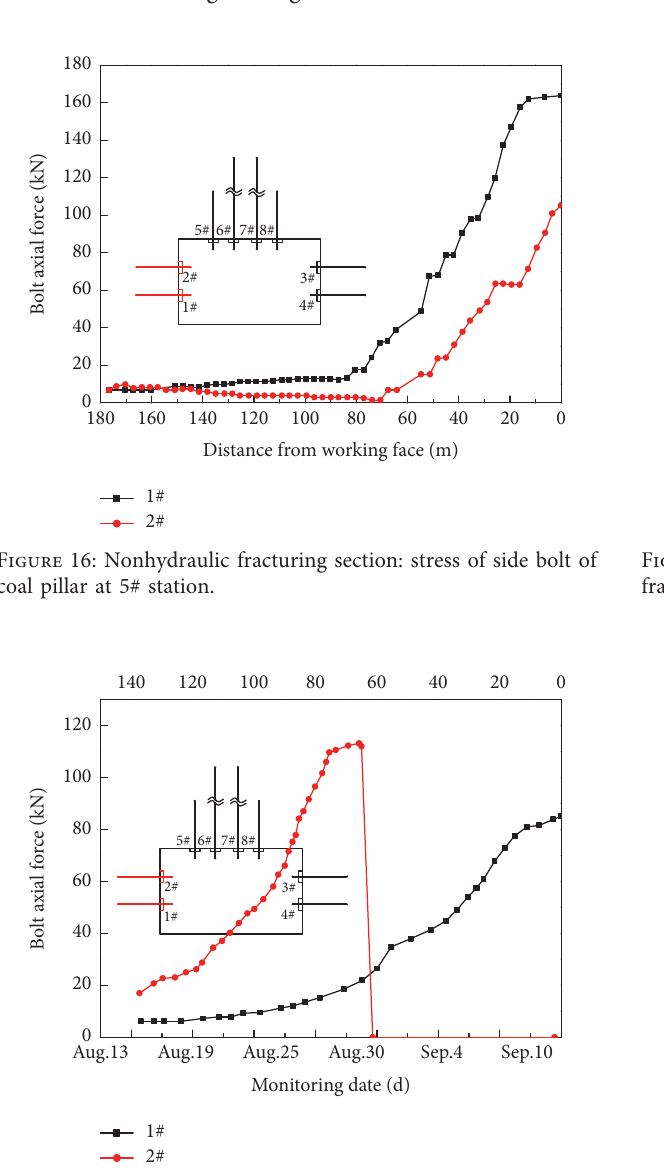
Figure 19: Stress of side bolt at 2# station in the hydraulic frac- turing